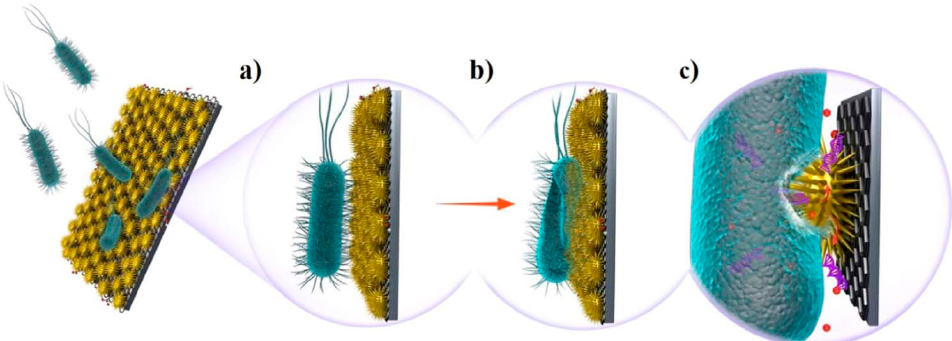
Figure 2. Scheme of the capture by the binding affinity of the electrode sensor and the E. coli bacteria ( a ), nano-piercing process on the bacterial wall ( b ) membrane damage, ( c ) cytoplasm leakage and killing of the bacteria [58]. Reproduced with permission.